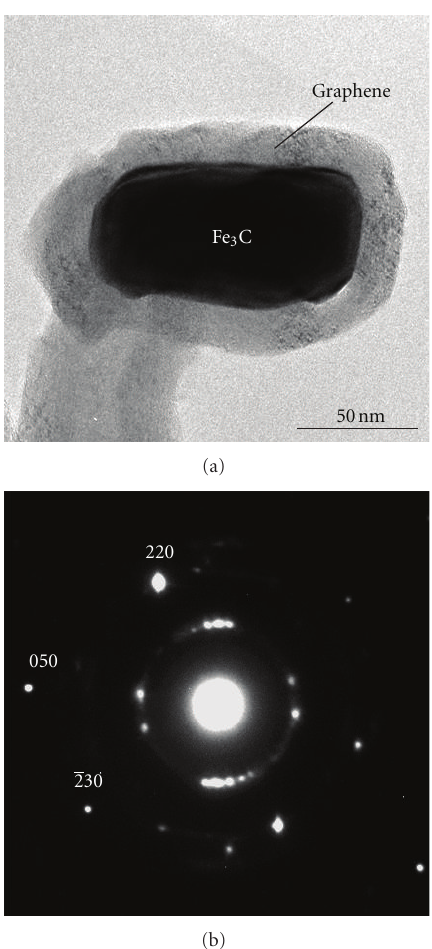
Figure 5: (a) Bright-field image and (b) selected-area di ff raction pattern of Fe 3 C-encapsulated carbon nanocapsule. The 220, 230, and 050 spots of Fe 3 C are